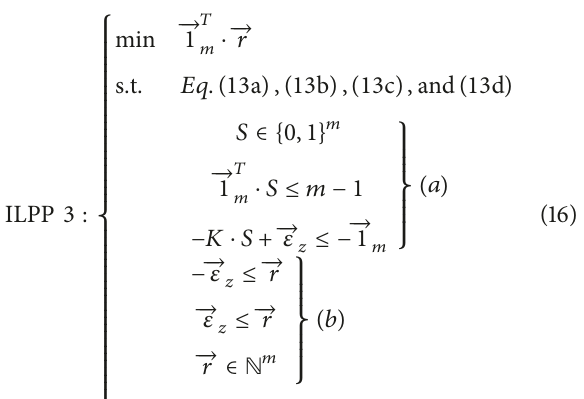
objective function into linear constraints. The final integer